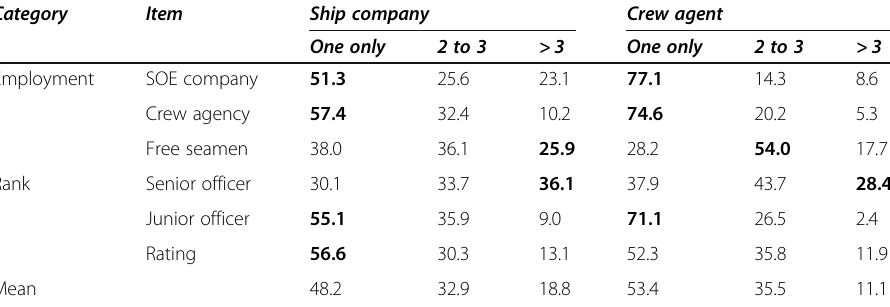
Table 3 Mobility of respondents across ship company and crew agency (%) Category Item Employment